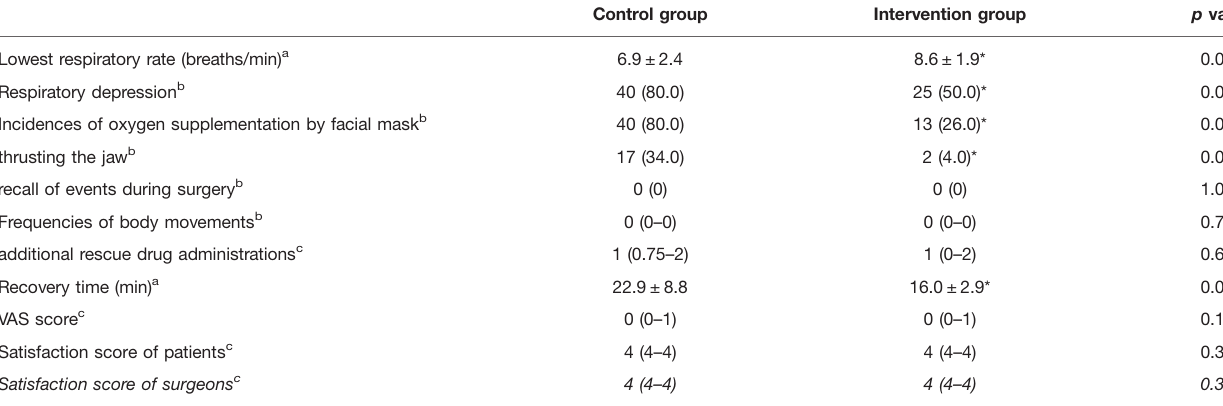
TABLE 4 | Assessments of intraoperative events and evaluations in